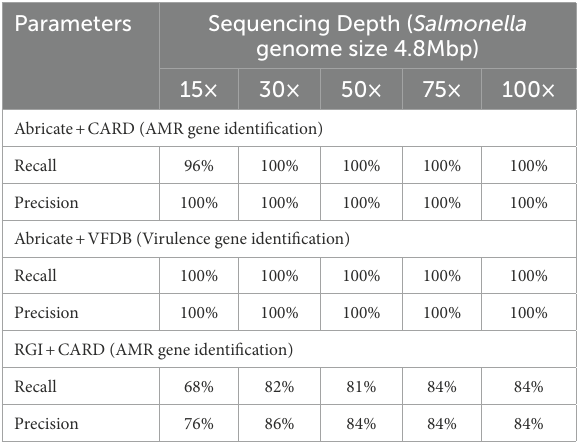
TABLE 7 Recall and precision of AMR/virulence gene identification for Salmonella serotype Typhimurium using assemblies from WGS data at different sequencing